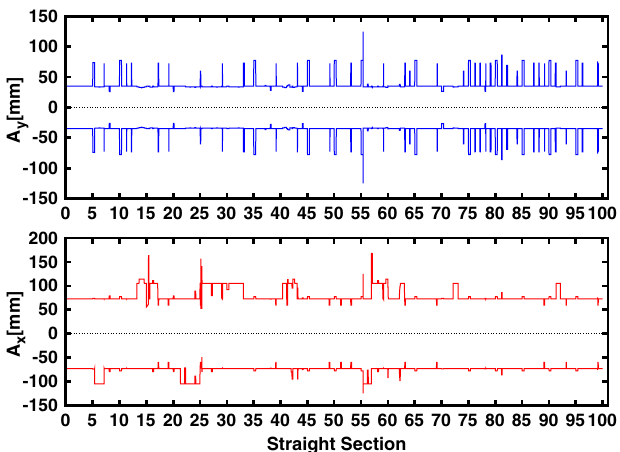
FIG. 13. PS aperture model in mm. Vertical (top), horizontal (bottom).